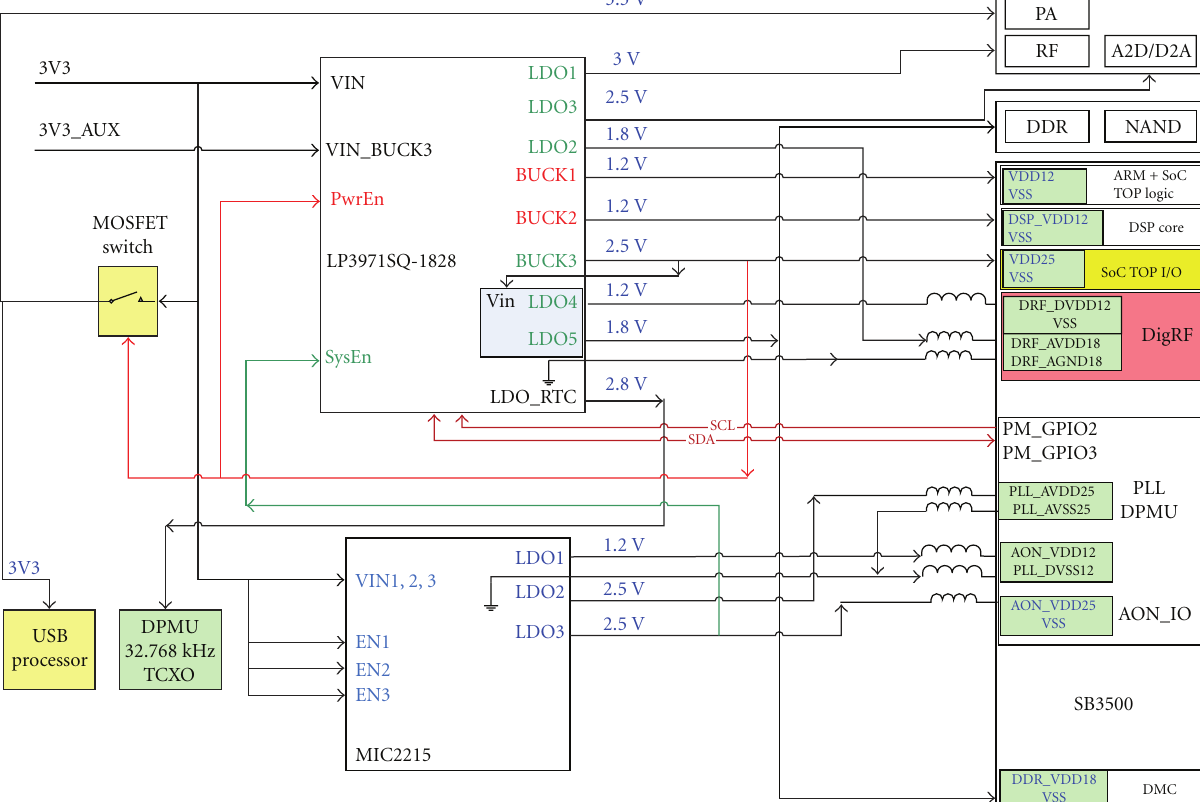
Figure 4: Power supply block